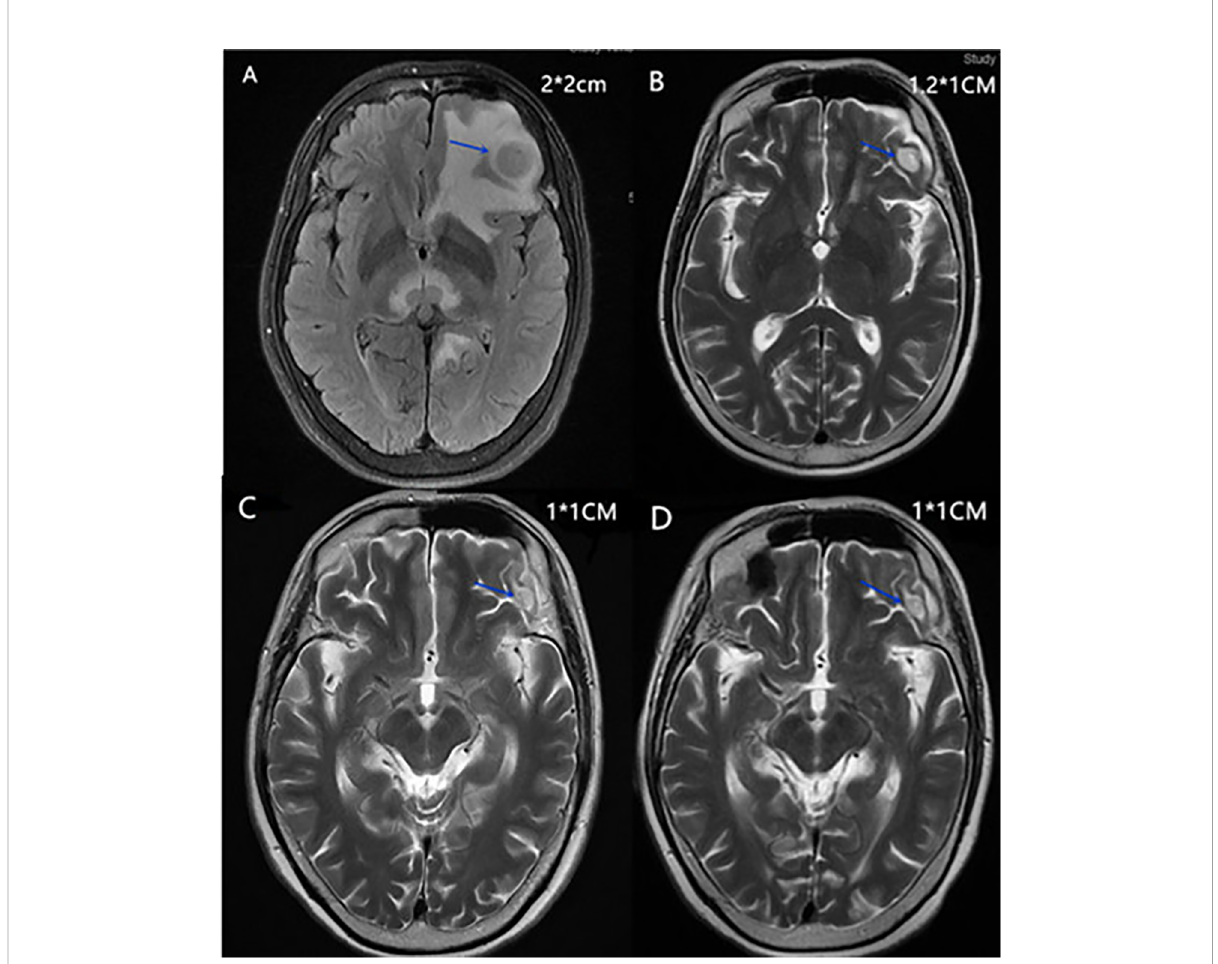
FIGURE 2 (A) Head MRI of the maximal mass in the left frontal lobe of the brain in April 2020. (B) Head MRI of the maximal mass in the left frontal lobe of the brain in May 2020. (C) Head MRI of the maximal mass in the left frontal lobe of the brain in August 2020. (D) Head MRI of the maximal mass in the left frontal lobe of the brain in April